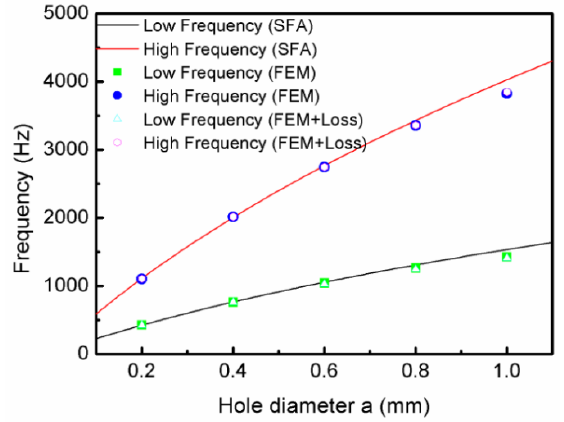
Figure 3. The relationship curves of the hole diameter and the resonant frequencies.